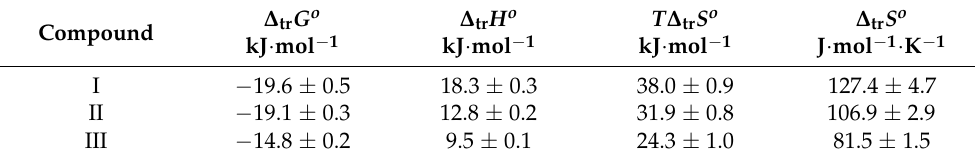
Table 6. Thermodynamics functions of transfer for compounds studied in system 1-octanol/buffer pH 7.4 at 298.15 K and p = 0.1 MPa. The standard uncertainties are u(T) = 0.15 K, u(p) = 3 kPa.